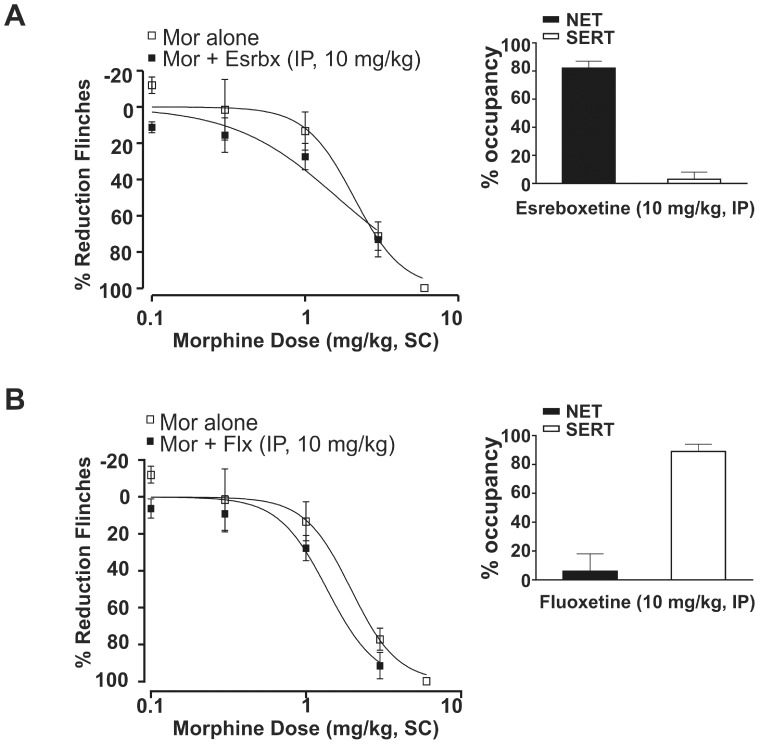
Neither esreboxetine nor fluoxetine exhibited antinociceptive synergy with morphine in the rat formalin model.(A) The selective NET inhibitor esreboxetine alone (Esrbx, IP, 10 mg/kg), failed to shift the morphine (Mor) dose-response curve (n = 6). Morphine alone: ED50 = 2.0 mg/kg (95% CI: 1.8–2.5); morphine+ esreboxetine (IP, 10 mg/kg): ED50 = 1.6 mg/kg (95% CI: 1.1–2.4). All data points are shown as mean ± SEM for each group and are expressed as percentage of controls. Inset (A) Esreboxetine (IP, 10 mg/kg) was associated with 82±5% NET and 3±5% SERT occupancy measured ex vivo at 75 min post-dose. All occupancy data represent mean (± SEM) for each group. (B) The selective SERT inhibitor fluoxetine alone (Flx, IP, 10 mg/kg), failed to shift the morphine dose-response curve (n = 6). Morphine+fluoxetine (IP, 10 mg/kg): ED50 = 1.6 mg/kg (95% CI: 1.2–2.2). Inset (B) Fluoxetine (IP, 10 mg/kg) was associated with 6±12% NET and 89±5% SERT occupancy measured ex vivo at 75 min post-dose.